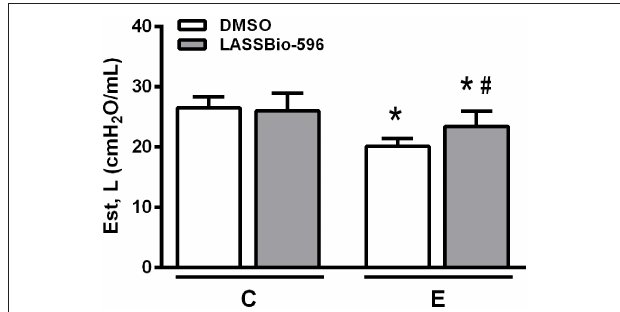
FIGURE 3 | Static lung elastance (Est,L). Values are means ( ± SD) of six animals in each group. C-DMSO: mice received intratracheal saline and were treated with DMSO. C-LASSBio-596 mice received intratracheal saline and were treated with LASSBio-596. E-DMSO: mice received intratracheal porcine pancreatic elastase and were treated with DMSO. E-LASSBio-596: mice received intratracheal porcine pancreatic elastase and were treated with